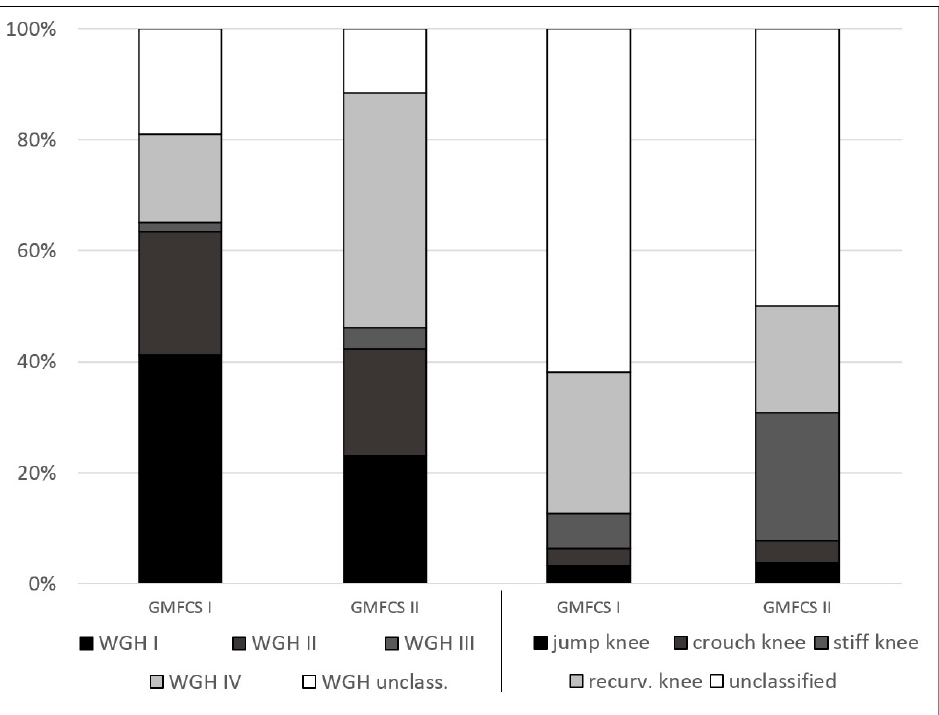
Figure 2. Percentage distribution of Gross Motor Function Classification System (GMFCS) levels within the different morphologic subgroups.